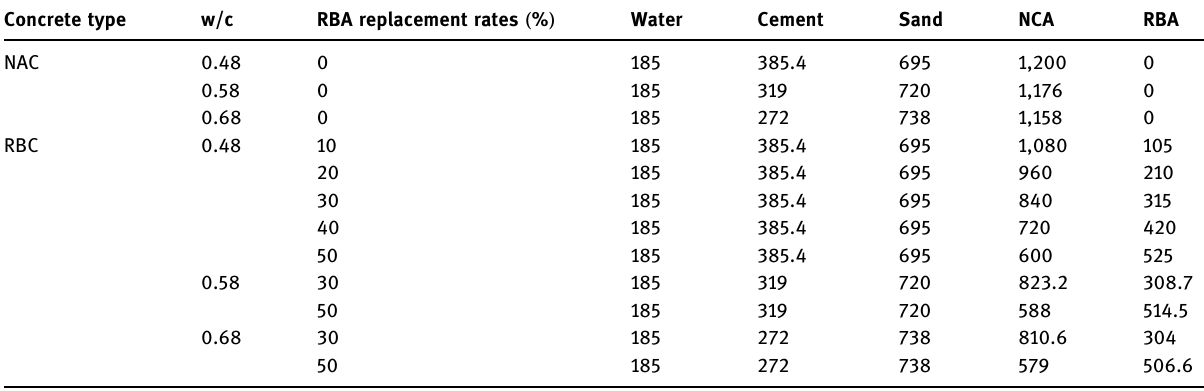
Table 1: Mix proportions ( kg · m − 3